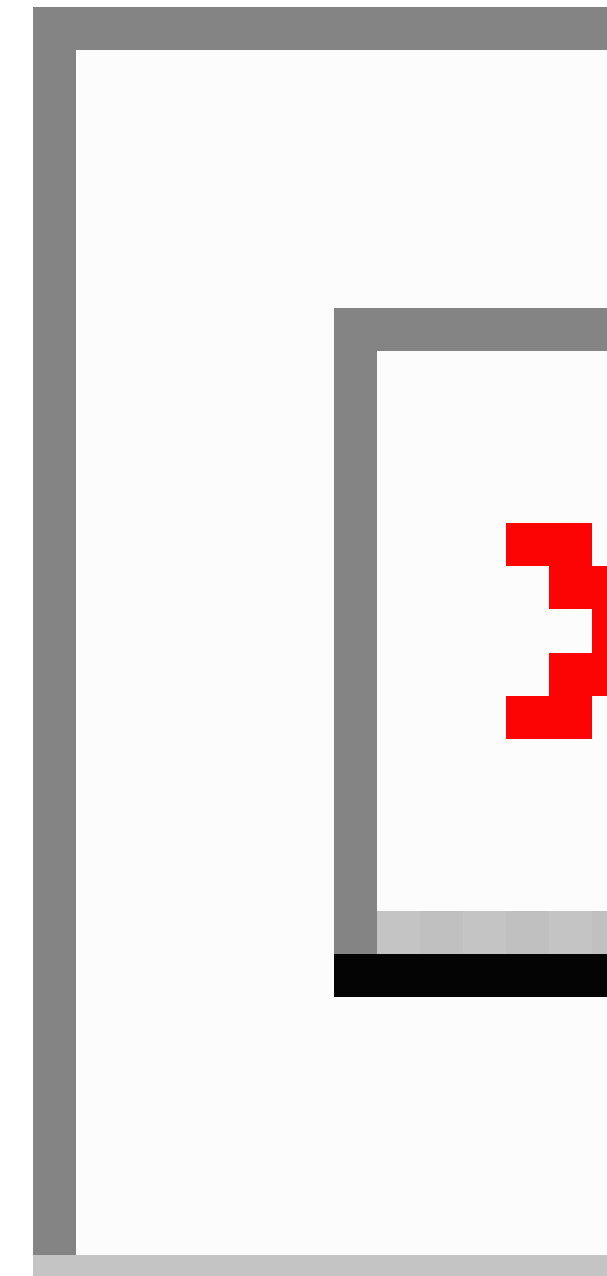
Figure 5. Entity-relation diagram of the